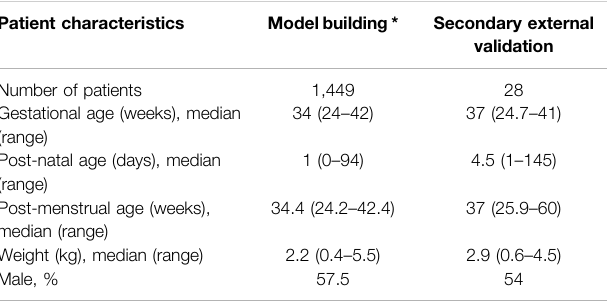
TABLE 2 | Demographic characteristics of patients used for model building and secondary external